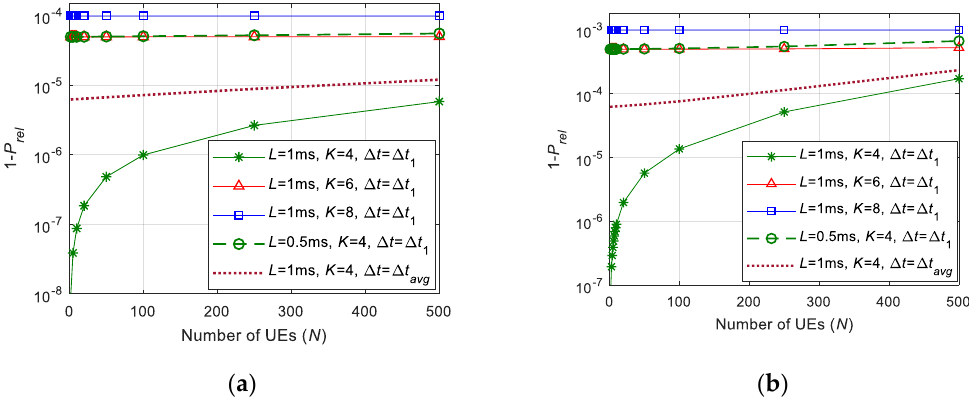
Figure 7. Reliability for different latency requirements L and number of repetitions K ( U = 6): ( a ) λ = 0.1 packets; ( b ) λ = 1 packet.